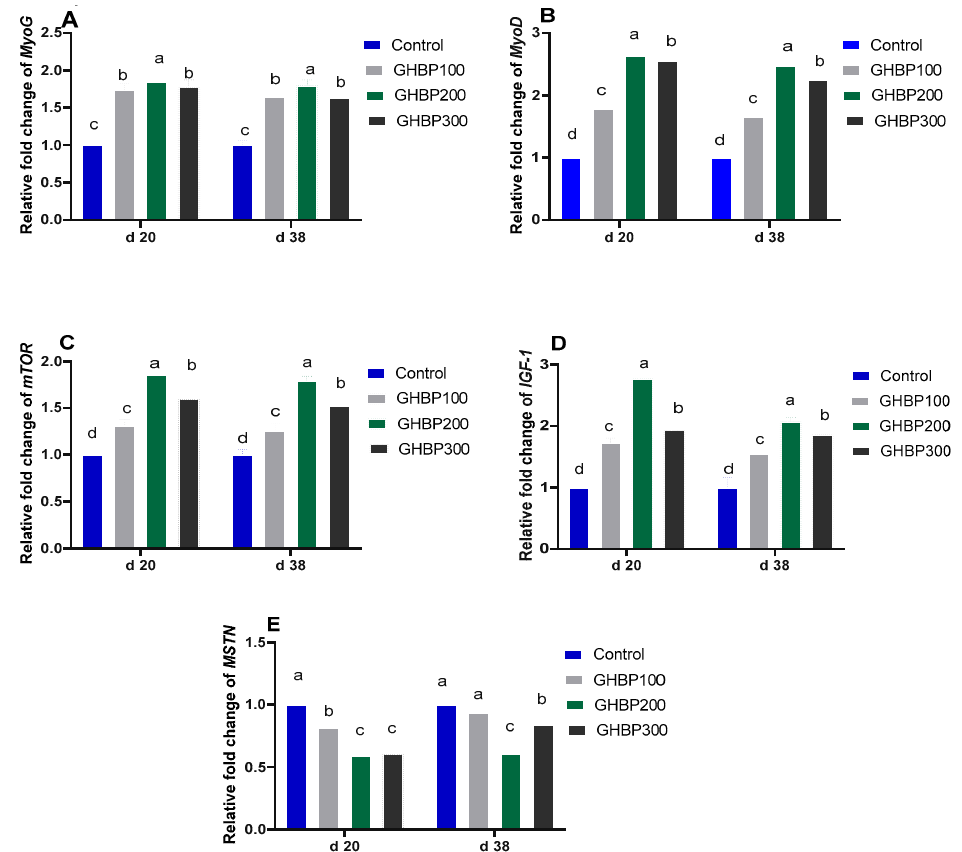
Figure 1. Real-time qPCR analysis for muscle development-related genes ( MyoG ( A ); MyoD ( B ); MTOR ( C ); IGF-1 ( D ); MSTN ( E )) expression in broiler chickens supplied with GHBP at day 20 and day 38 of age. GHBP: growth hormone- boosting peptide; MyoD: myogenic determination factor; MyoG: myogenin; MSTN: myostatin; mTOR: mechanistic target of rapamycin; IGF-1: insulin-like growth factor 1. Bars with different letters above them correspond to values that were significantly different ( p < 0.05). Control: basal diet without GHBP; GHBP100: basal diet plus GHBP at a level of 100 µ g/kg; GHBP200: basal diet plus GHBP at a level of 200 µ g/kg; GHBP300: basal diet plus GHBP at a level of 300 µ g